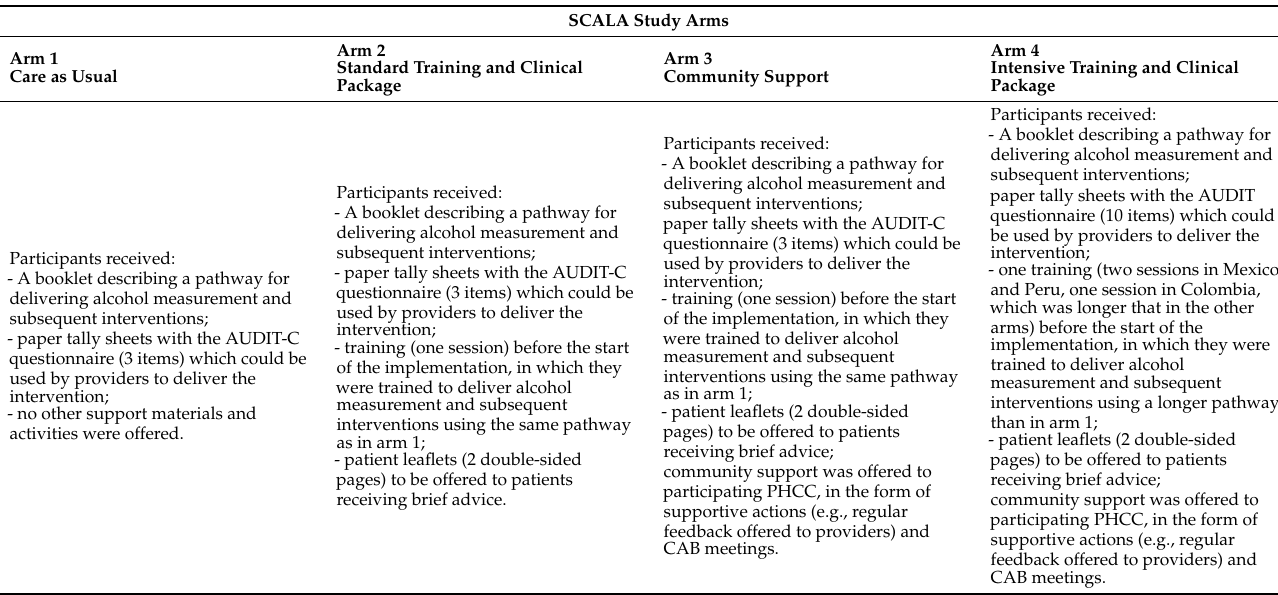
Table A2. Alcohol measurement-related activities and materials offered to participants in different study arms.